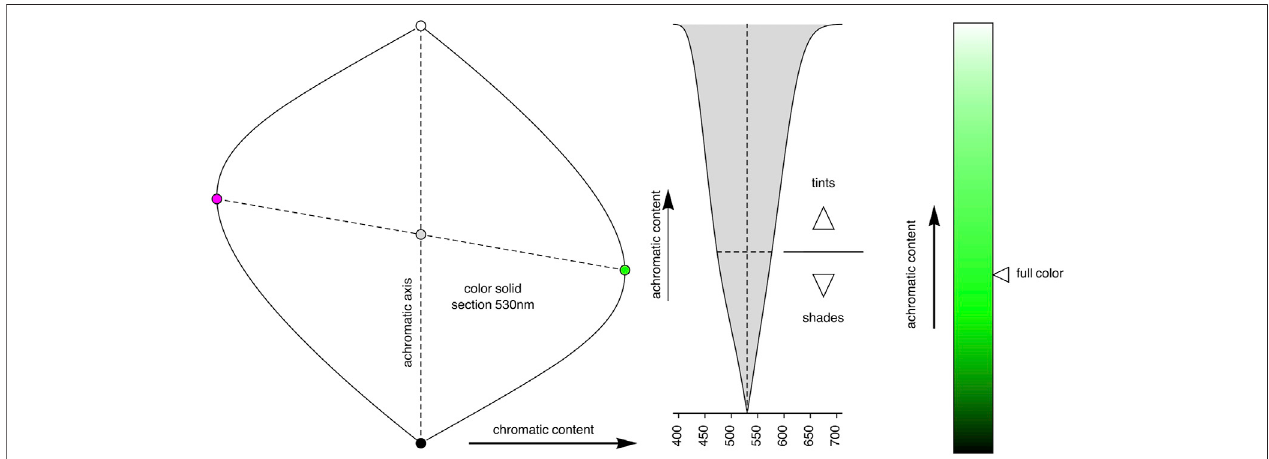
FIGURE 6 | Example of a section of the color solid through the spectrum generator labeled 530 nm (left fi gure) . There is no complementary wavelength. Optimal colors of that type tend to look Y green although some are Y greener than others. The differences are due to the spectral width of the optimal color pass band (center fi gure) . At right are the computed colors. Indeed, all are Y greenish , but some are extreme Y tints or Y shades of Y green